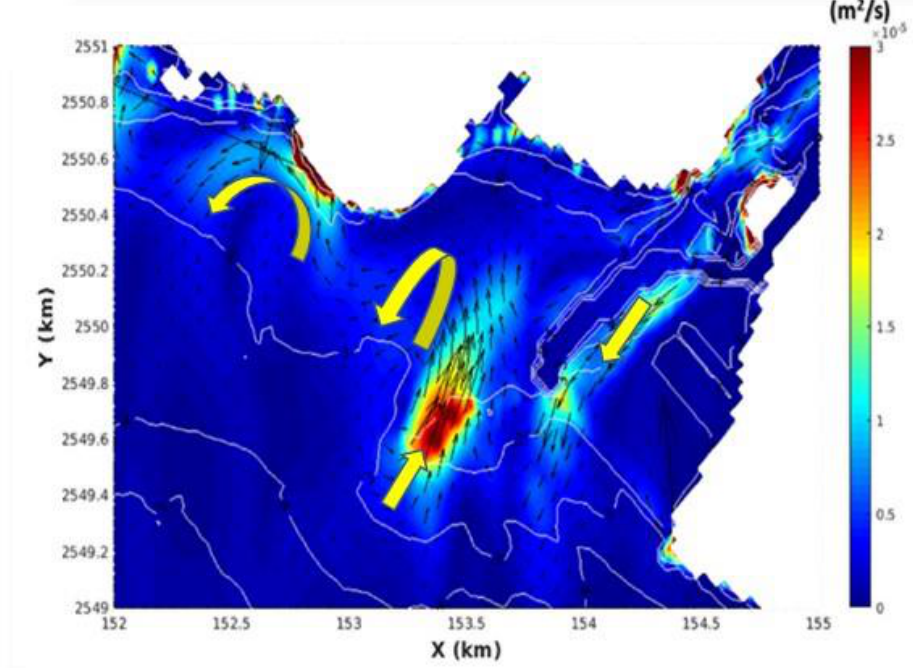
Figure 11. The modeled residual sediment flux (vector: transport direction, scale on the right, con- tour: depth) under the northeast monsoon (winter) condition during 21–28 November 2018. depth) under the northeast monsoon (winter) condition during 21–28 November